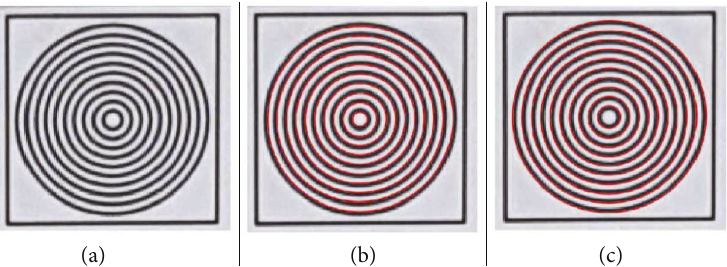
Figure 5: The result of the ellipse detector is the target itself (a), shows the inner ellipses detected (b), and shows the outer ellipses detected